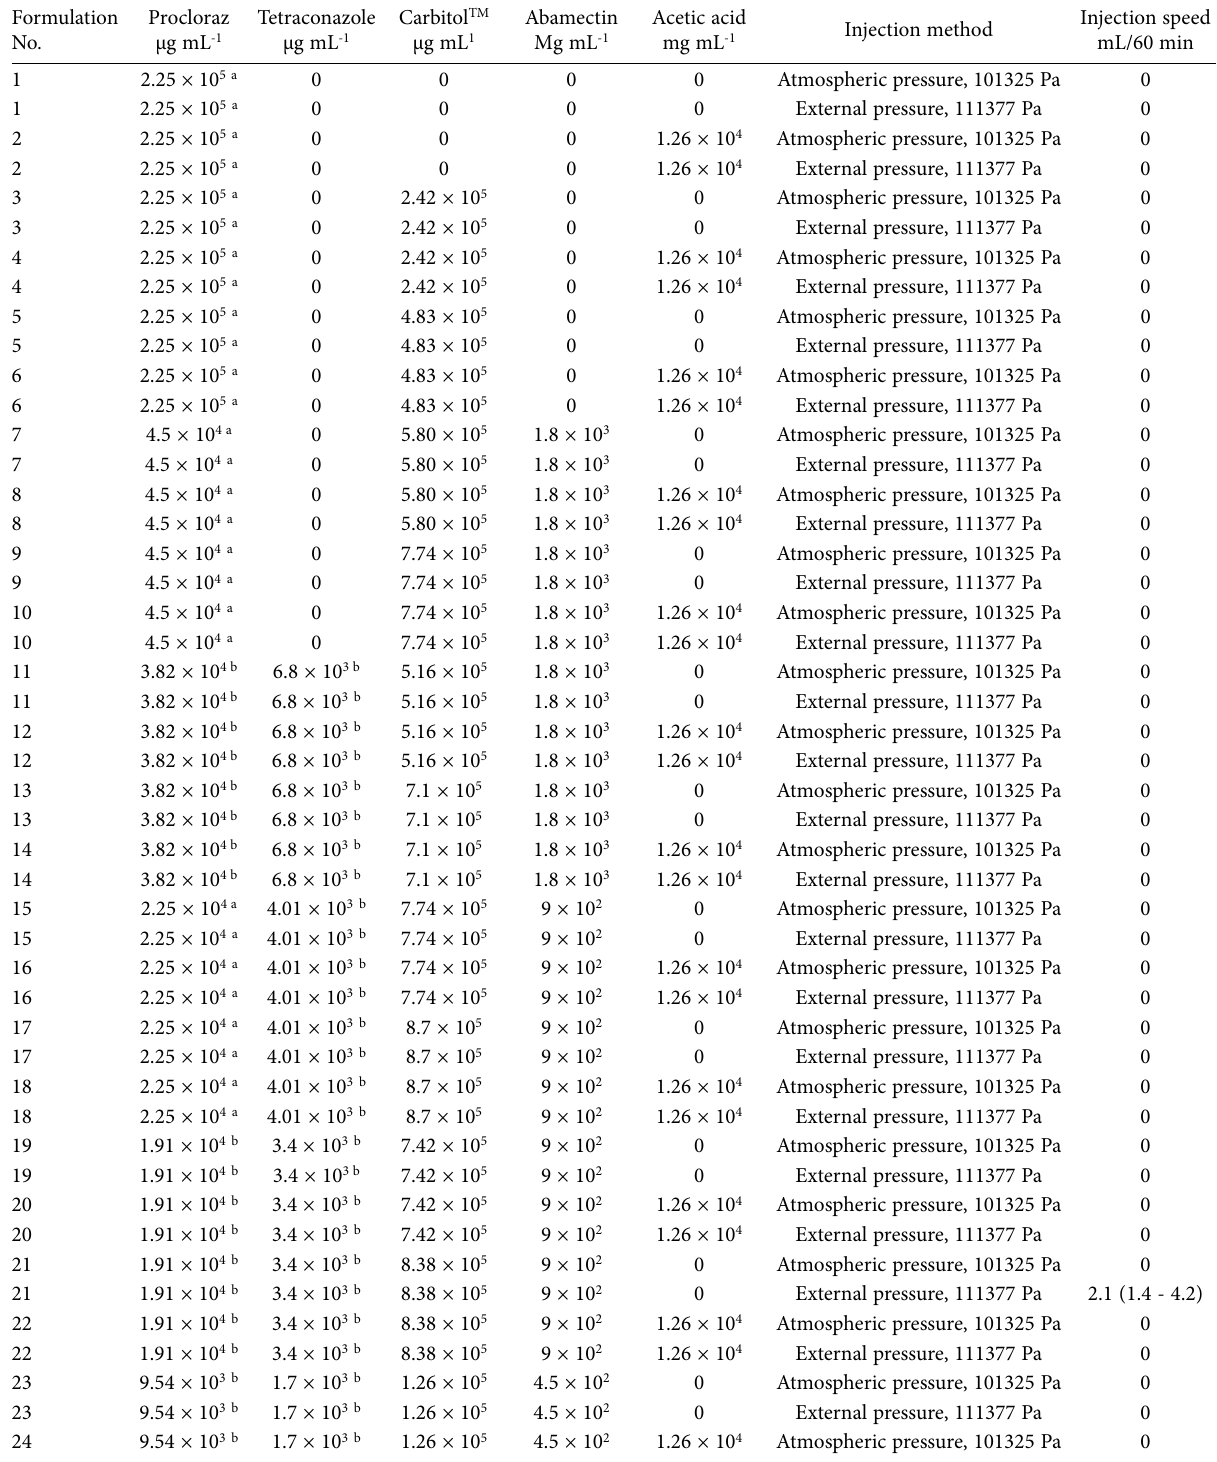
Table 2. Average volumes of solutions injected into Juglans nigra trees during 60 min, for 28 different formulations tested on at atmospheric pressure or manually applied external pressure, as obtained in the pesticide uptake rate test. a = Sportak 45 EW commercial product; b = Binal Pro commercial